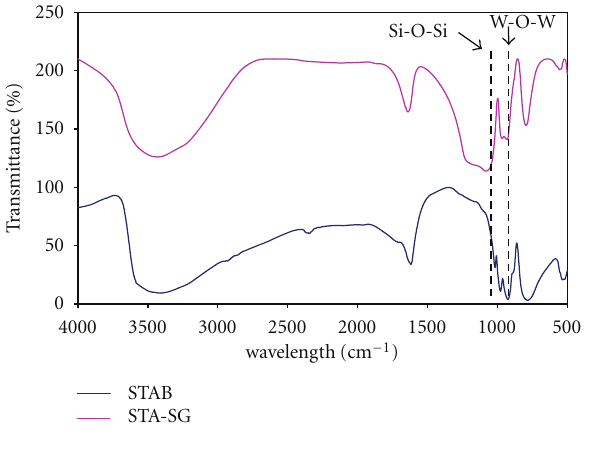
Figure 2: XRD di ff ractogram of STAB and